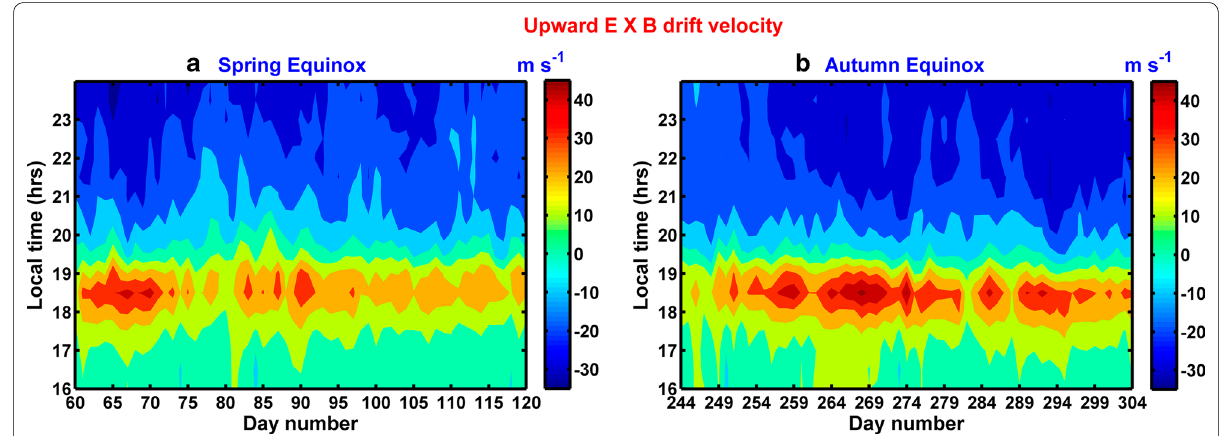
Fig. 1 Day-to-day variation of upward E B drift velocity with respect to local time at an altitude of 300 km during a spring equinox (March–April) × and b autumn equinox (September–October) of 2011 over (10° N, 100° E; GAIA co-ordinates) near Chumphon in